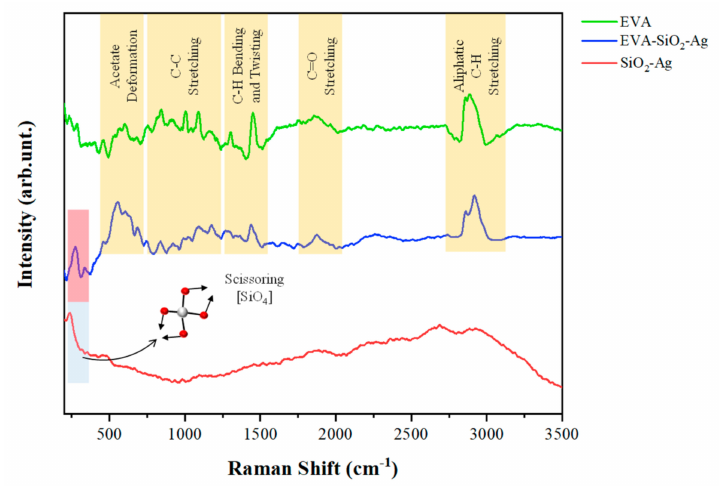
Figure 2. Micro-Raman spectra of SiO 2 -Ag, EVA-SiO 2 -Ag, and EVA samples. Fourier-transform infrared spectroscopy (FTIR) was performed to analyze changes in the functional groups of the samples and to verify the formation of the composite EVA- SiO 2 -Ag (Figure 3). For SiO 2 -Ag, there is a broad band located near 3400 cm − 1 and another located at 1627 cm − 1 , both corresponding to the O–H stretching of water and the formed silanol groups (Si–OH), respectively [92,93]. The bands observed at 1100 and 475 cm − 1 , on the other hand, are attributed to symmetrical stretching and bending of Si–O–Si bonds, respectively [92,94,95]. The peaks located at 950 and 845 cm − 1 indicate the bending of the O–Si–O moiety [80,95]. The low-intensity mode located at 552 cm − 1 can be attributed to Ag-O stretching, showing the presence of Ag in SiO 2 -Ag [96,97]. For EVA, bands referring to the fingerprint of the polymer are observed at 2954, 2850, 1467, 1243, 874, 707, and 546 cm − 1 , related to the EVA aliphatic groups [98–102]. At 1020 cm − 1 , the bending of the C–O–C bonds is observed [102], and at 1801 and 1739 cm − 1 , the C=O bond stretching refers to two different types of carbonyl groups [101,102], as noted by Poljansek et al. [103]. For the EVA-SiO 2 -Ag composite, changes are observed especially for the stretching of the C=O bonds and throughout the low-wavelength region, where the SiO 2 vibrational modes appear. This is because EVA monomers interact through ionic and van der Waals forces with SiO 2 and Ag, shown by the overlap of some vibrational modes of the samples and the appearance of new ones. These findings indicate the interactions between the polymer, at short and long range, with the particles of SiO 2 and